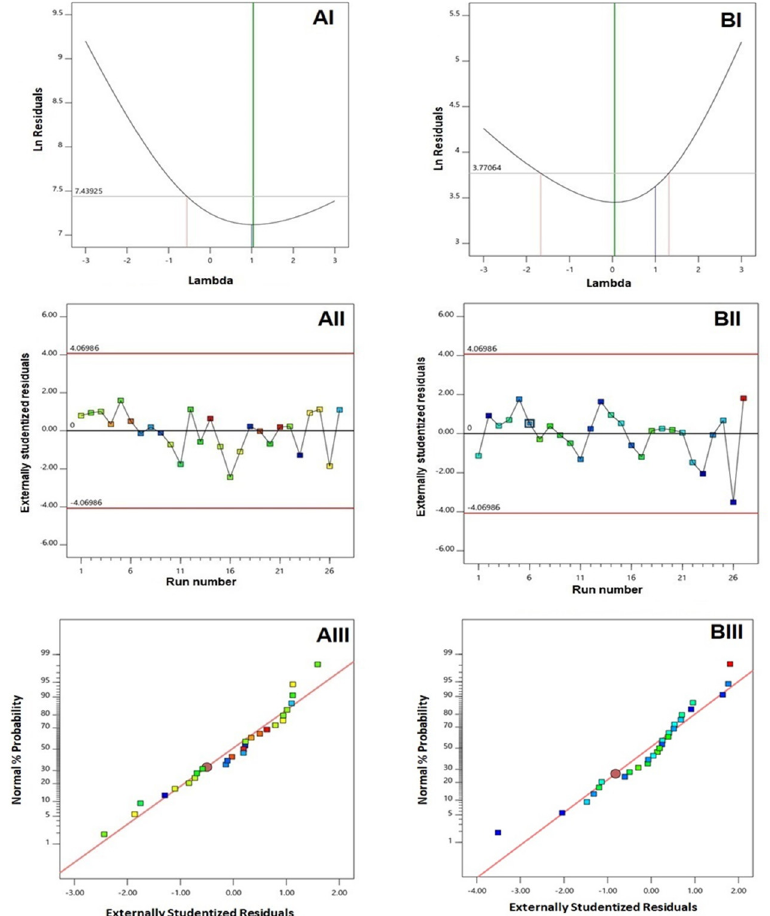
Figure 1. Diagnostic plots for responses of QRT-PHM-SV formulations. ( AI ) Box-Cox Plot for VS; ( AII ) Externally studentized residuals vs. run number plot for VS, ( AIII ) Normal probability plot for VS, ( BI ) Box-Cox Plot for ZP; ( BII ) Externally studentized residuals vs. run number plot for ZP, ( BIII ) Normal probability plot for ZP. Abbreviations: QRT, quercetin; PHM, phytosomes; SV, scorpion venom peptide, VS: vesicle size, ZP, zeta potential.